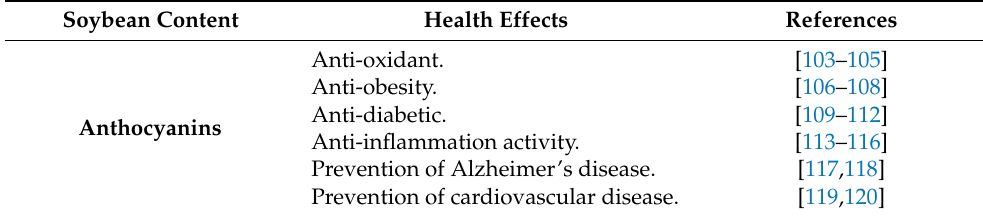
Table 6. Major health effects brought about by